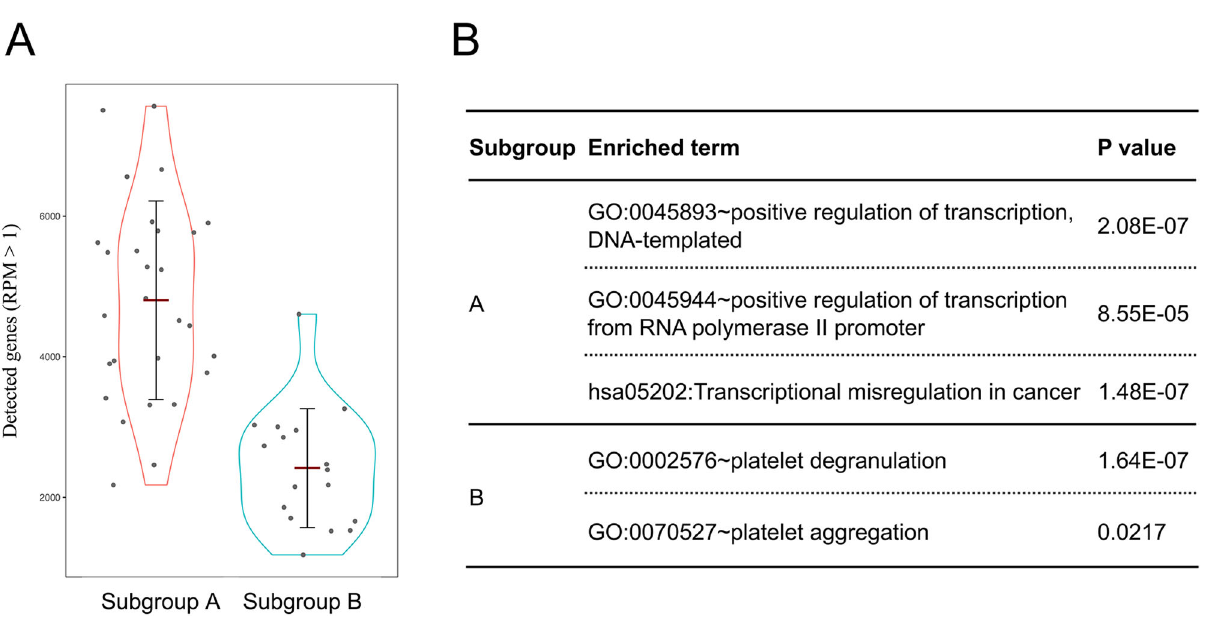
Fig. 5 Comparison of subgroup A and B. A Comparison of the number of detected genes (RPM> 1) between subgroup A and B. Each dot represents a single-cell. The red bar represents mean value. The black bar represents deviation. B Gene ontology analysis of enriched